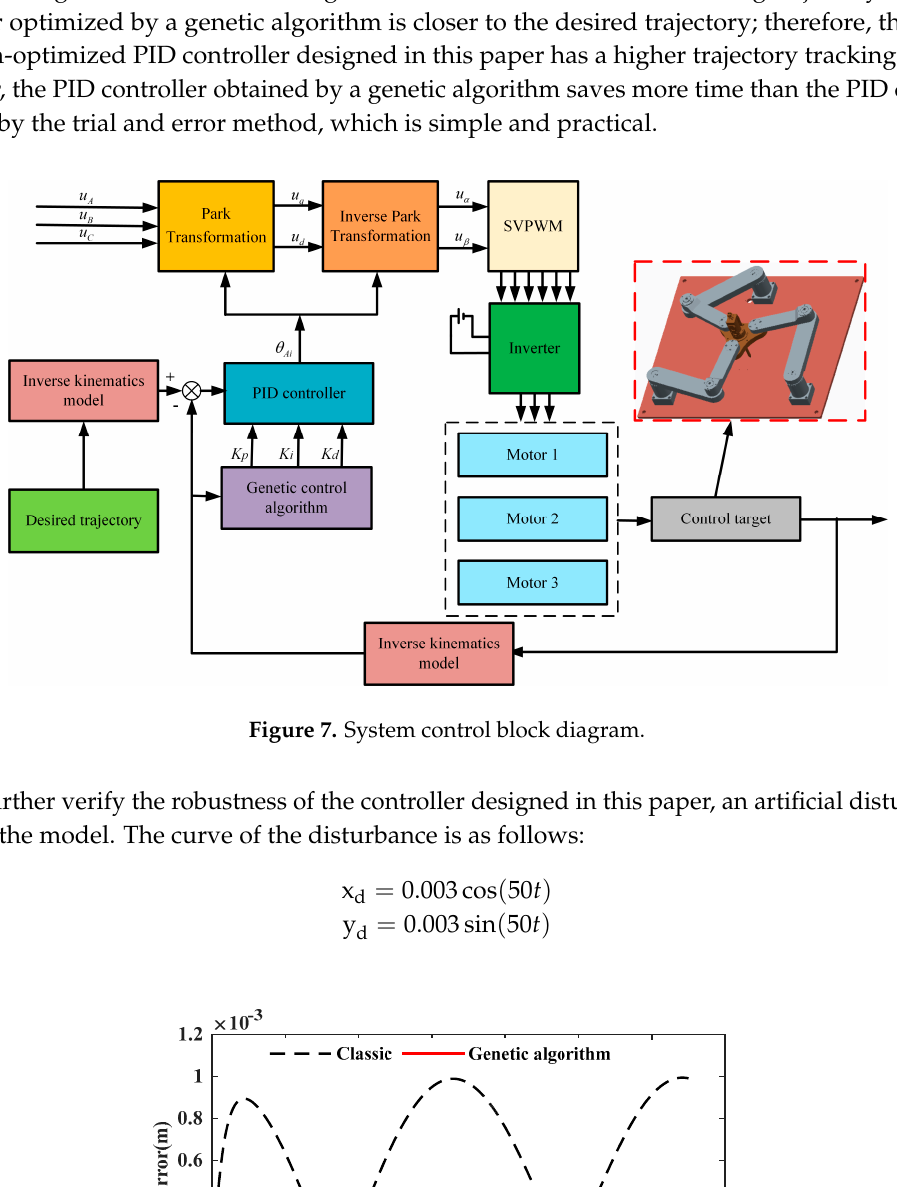
Figure 8. The trajectory tracking errors of the classic PID and the PID optimized by a genetic algorithm.